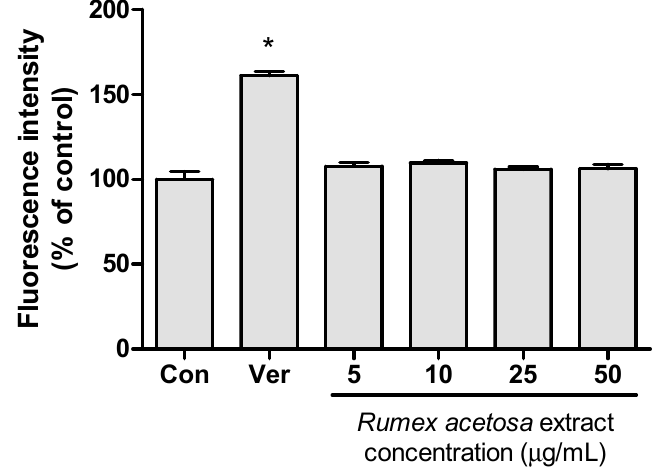
Figure 3. P-gp inhibition test of R. acetosa extract using an MDR kit in Caco-2 cells ( n = 6). Con—vehicle treated control; Ver—100- µ M verapamil; *— p < 0.05 compared to control group.